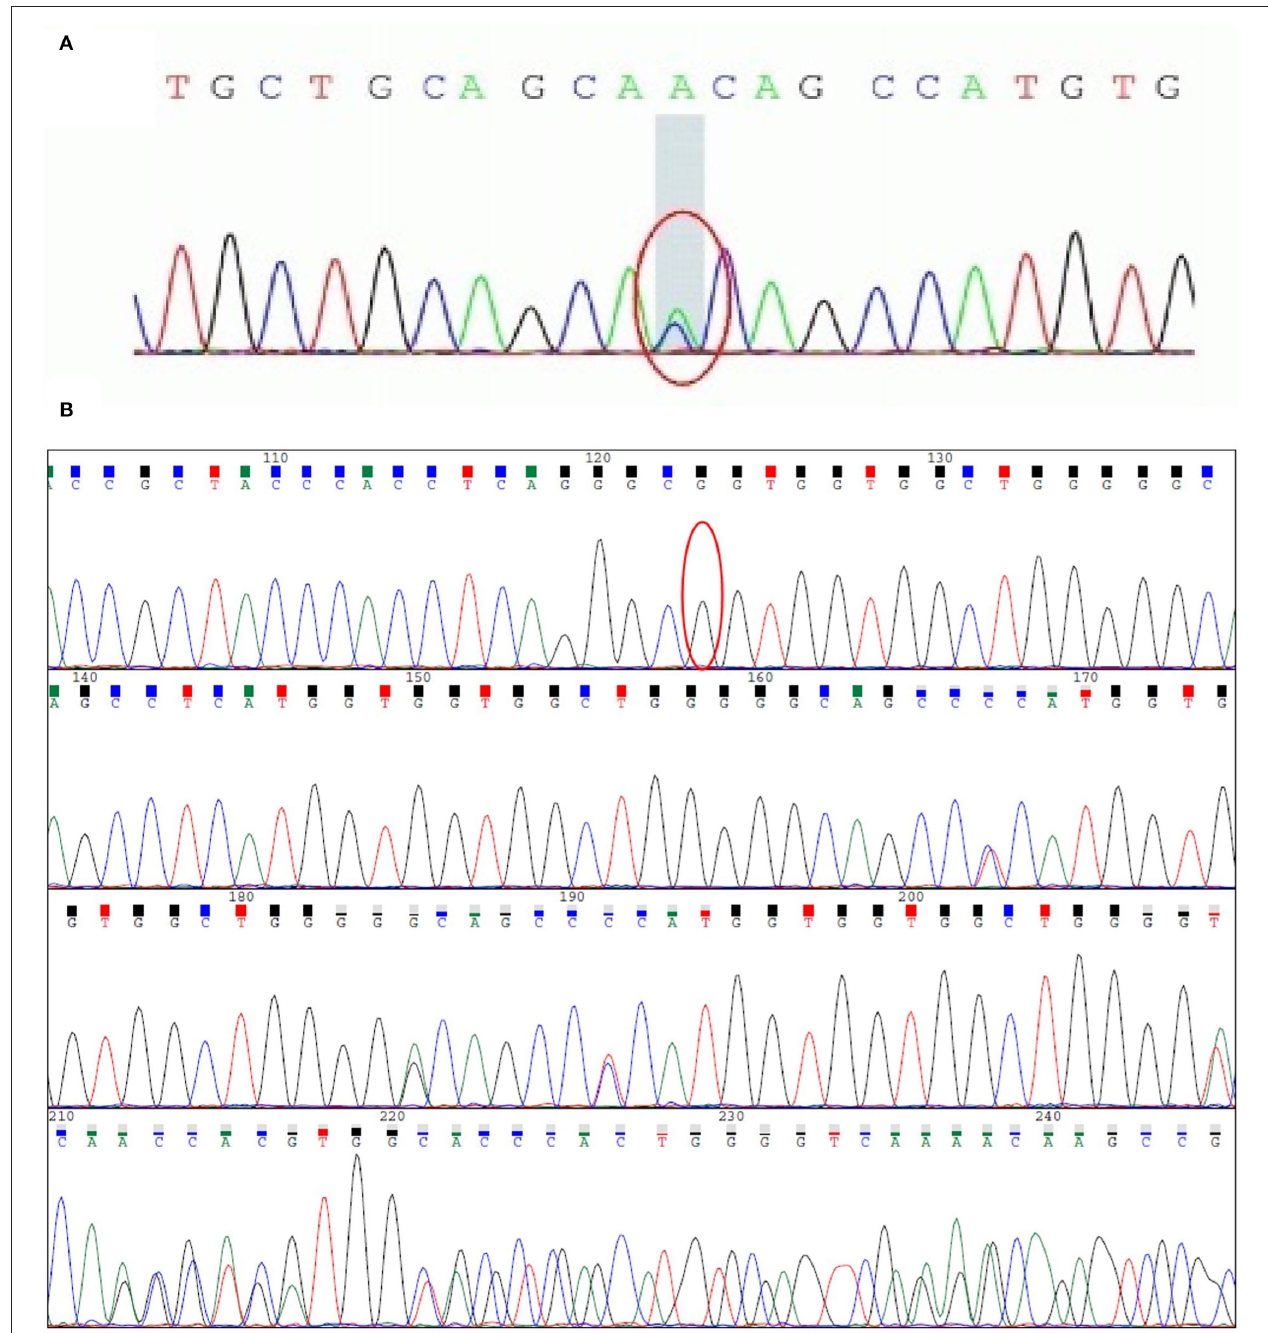
FIGURE 5 | Sequencing analyses in the PRNP gene from patient III-10. (A) c.341G > T (p.G114V) variant of the PRNP gene was detected. The mutation leads to the alteration of amino acid from glycine-to-valine. This alteration will lead to prion disease. (B) c.204_227 delTCATGGTGGTGGCTGGGGGCAGCC (1-OPRD) variant was detected. PRNP gene comprises two exons with the entire open reading frame (ORF) of 762 bp which is contained with exon 2. Nuclides between PRNP codon 51-91 into N-terminal are 5 groups of 24 base pair (bp) repeats, a deletion of the repeat TCATGGTGGTGGCTGGGGGCAGCC was found at the end of the PRNP gene (bottom). This mutation can be found in a minority of people and its pathogenicity has not yet been determined.